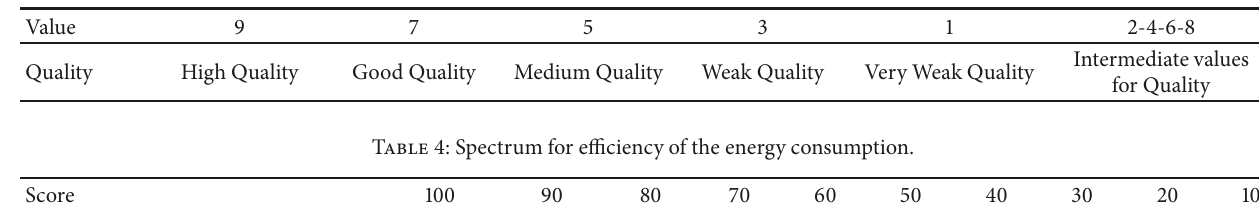
Table 3: 9-point Likert spectrum for Quality.